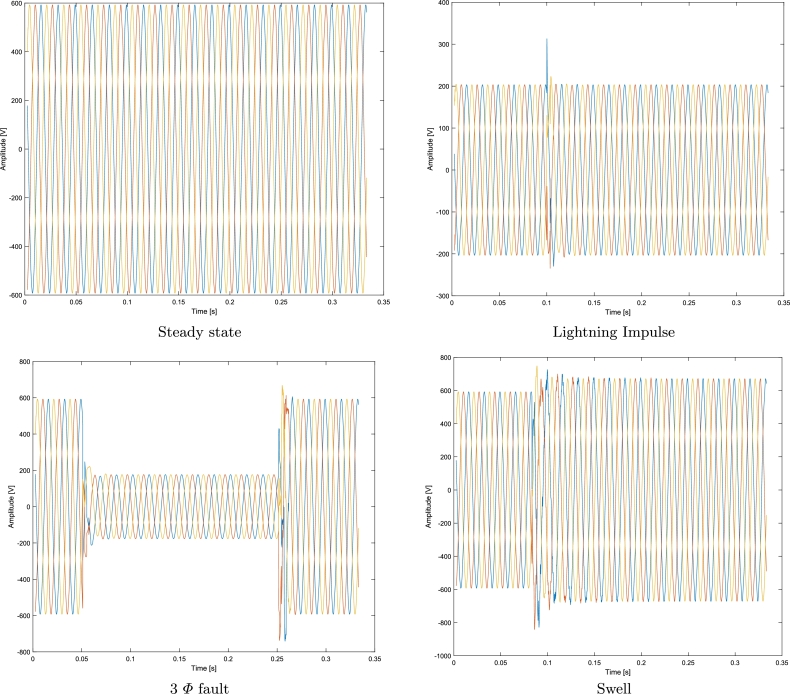
Original signals.